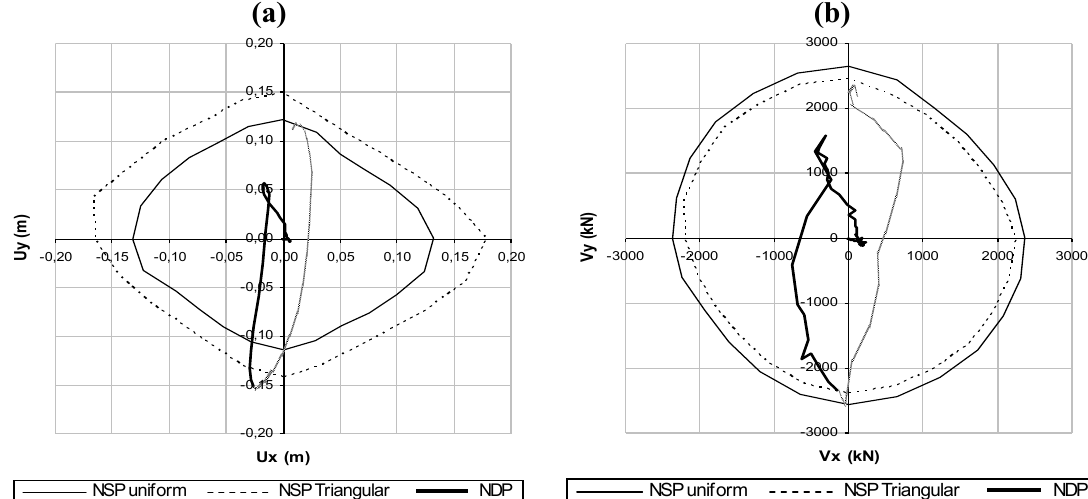
Figure 4. ( a ) Comparison between capacity domains and NDP-Collapse amplification factor 0.35-In plan orientation of benchmark structure 90°; ( b ) Comparison between capacity domains and NDP-Collapse amplification factor 0.35-In plan orientation of benchmark structure